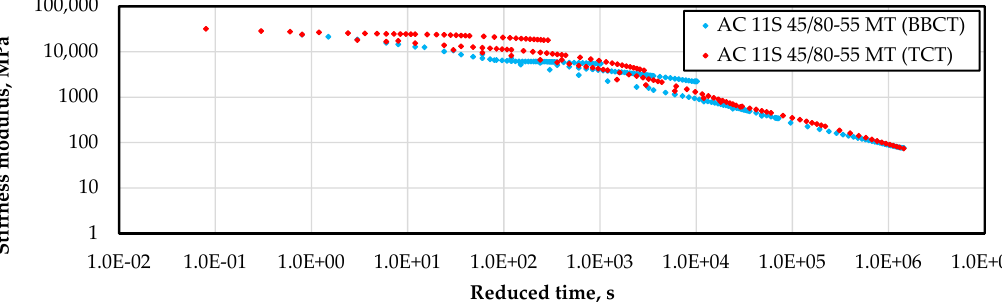
Figure 13. Comparison of shifted stiffness curves for AC 11S 45/80-55 MT, reference temperature: − 10 °C.